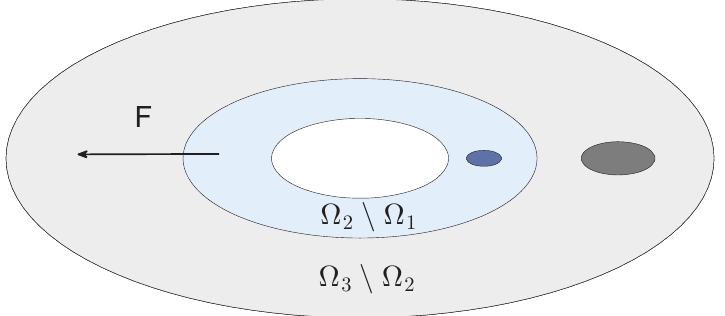
Figure 2: The media ( ε , μ ) in Ω 2 \ Ω 1 and ( ε , μ ) in Ω 3 \ Ω 2 are reflecting complementary media if roughly speaking ( F ∗ ε , F ∗ μ ) = ( ε , μ ) in Ω